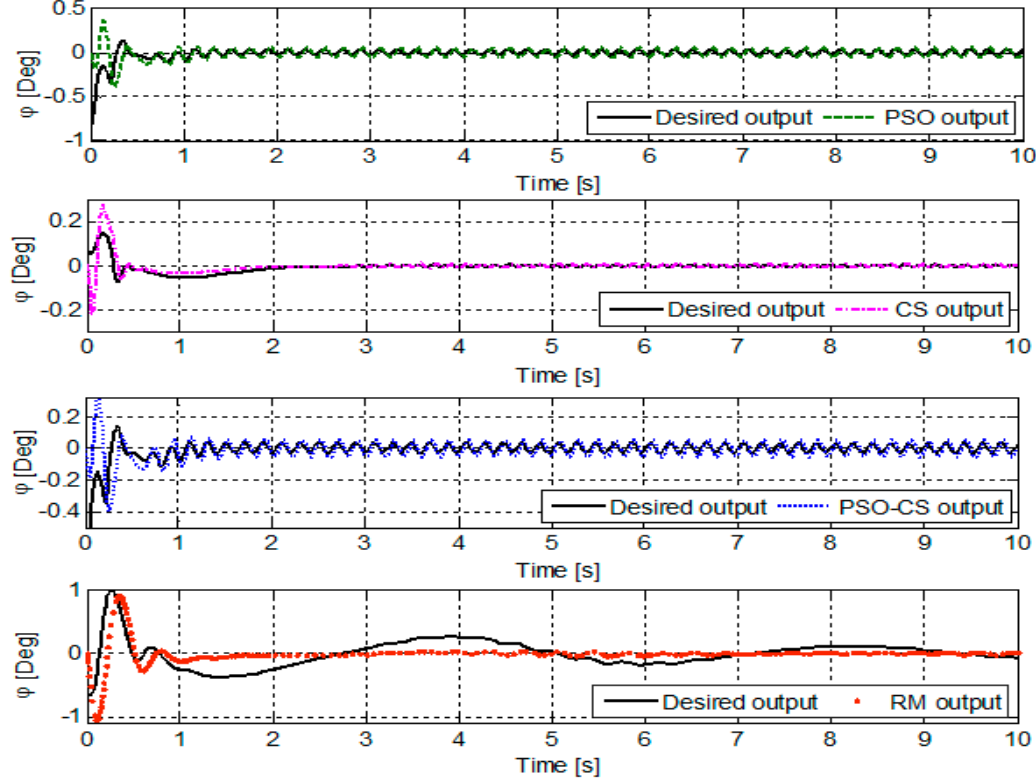
Figure 7. Quadrotor’s roll attitude ( ϕ ) using Particle Swarm Optimization (PSO), Cuckoo Search (CS), Particle Swarm Optimization-Cuckoo Search (PSO-CS), and Reference Model (RM).